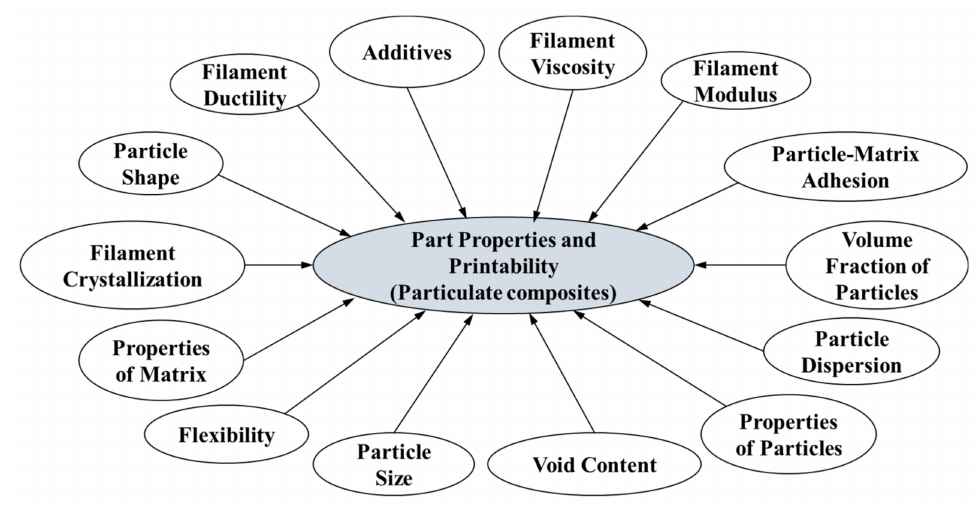
Figure 5. The factors for part properties and printability of particulate composite